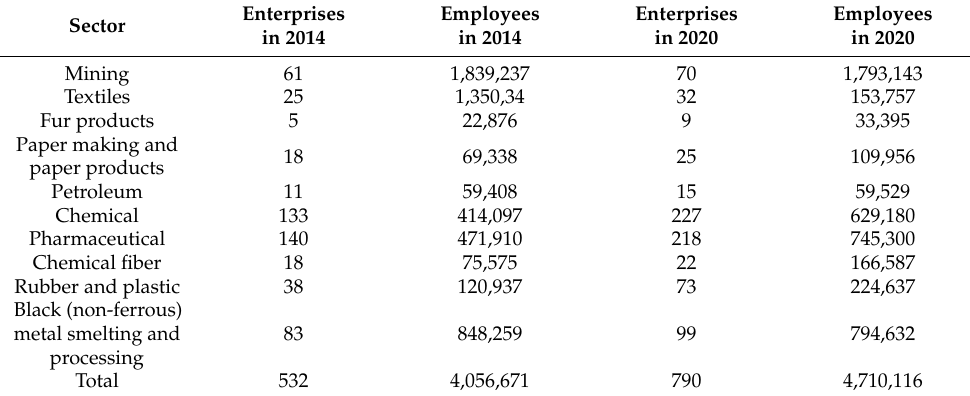
Table A1. The number of enterprises and employees by sector.